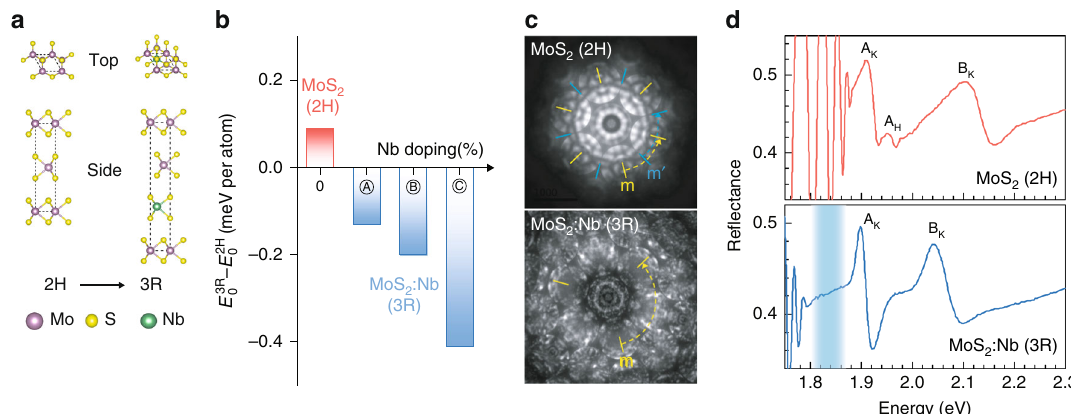
Fig. 1 Crystal structure of undoped and Nb-doped bulk MoS 2 . a Illustration of modi fi cation in stacking order polytypism of MoS 2 by Nb doping (top and side views). The dashed lines show the corresponding single unit cells of 2H and 3R structures. b Calculated energy difference of 3R phase with respect to 2H phase, with positive (negative) values indicating that the 2H (3R) phase is more stable. Bilayer MoS 2 system is considered for variable Nb doping concentrations (not to the scale). For the MoS 2 :Nb, Ⓐ and Ⓑ are obtained with a 6 × 6 supercell by adding 1 and 2 Nb dopants, respectively. Type Ⓒ is calculated by substituting a Nb dopant into a 4 × 4 supercell. So, their Nb doping concentrations correspond to 1.4, 2.8 and 3.1%, respectively. c Convergent beam electron diffraction patterns obtained from the undoped and Nb-doped multilayer MoS 2 at [0001] incidence. Both bulk crystals display mirror symmetries, indicated by yellow and blue lines, for the six-fold (MoS 2 , 2H) and three-fold (MoS 2 :Nb, 3R), respectively. d Optical re fl ectance spectrum of bulk MoS 2 and MoS 2 :Nb taken at 4.5 K. Two main peaks are assigned as A and B exciton transitions at the K point while the additional feature arising from H-point of the Brillouin zone is only observed in undoped MoS 2 . The strong absorption below the A exciton in MoS 2 :Nb is evidenced by the absence of the Fabry-Perot oscillation which appears in the Nb-free